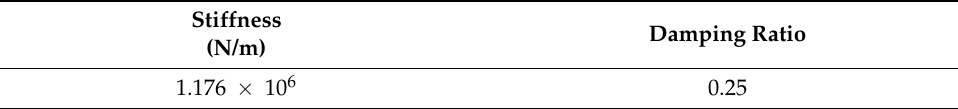
Table 4. Properties of the plate.